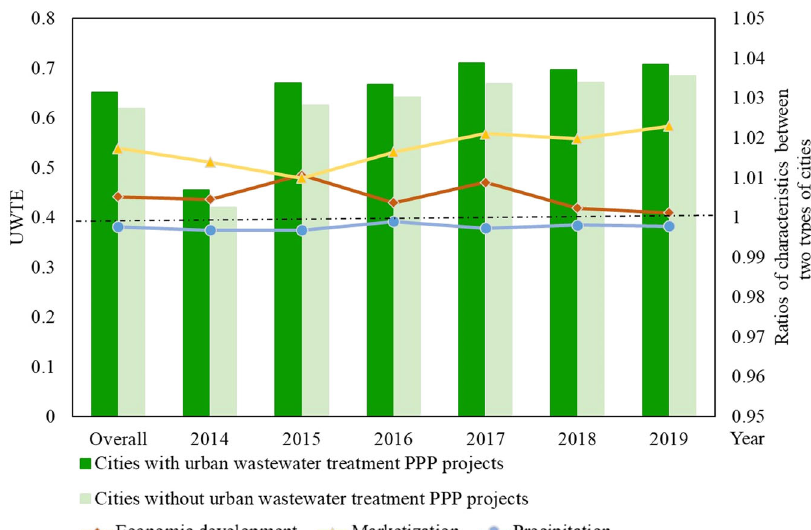
Fig. 2 Average UWTE with/without PPPs for wastewater treatment and comparison of characteristics in Chinese prefecture-level cities. The average UWTE from 2014 – 2019 in Chinese prefecture-level cities is shown. The height of the column represents the UWTE, and the higher the column, the larger the UWTE. The scattered dots of different colours represent the ratio of cities ’ characteristics with urban wastewater treatment PPP projects to cities that without urban wastewater treatment PPP projects. The scattered dots of red, yellow and blue represent the cities ’ economic development level, marketization level and precipitation, respectively. The horizontal black dashed line in the fi gure indicates that the ratio is 1, implying the same average conditions.